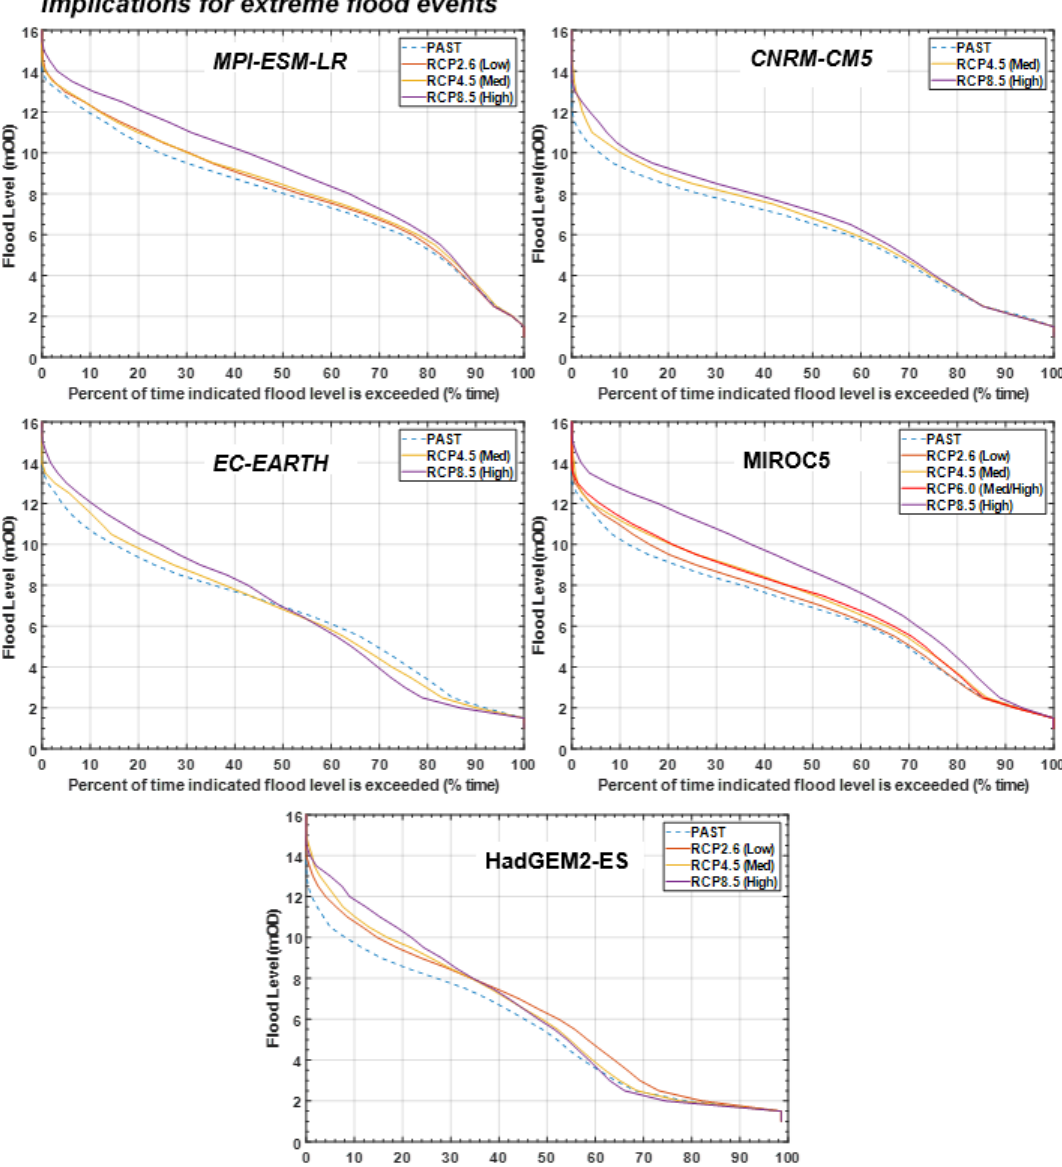
Figure 9. Flooded duration curves at Coole turlough for each of the RCM